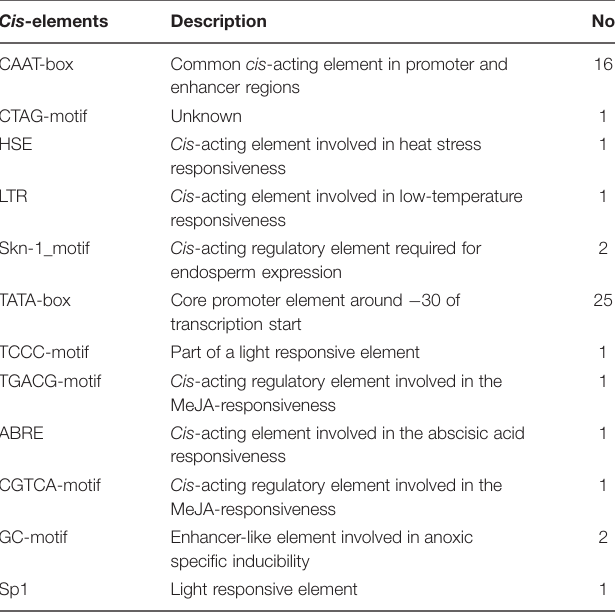
TABLE 2 | Known cis -acting elements in the pZmPIS using the PlantCARE and PLACE databases.